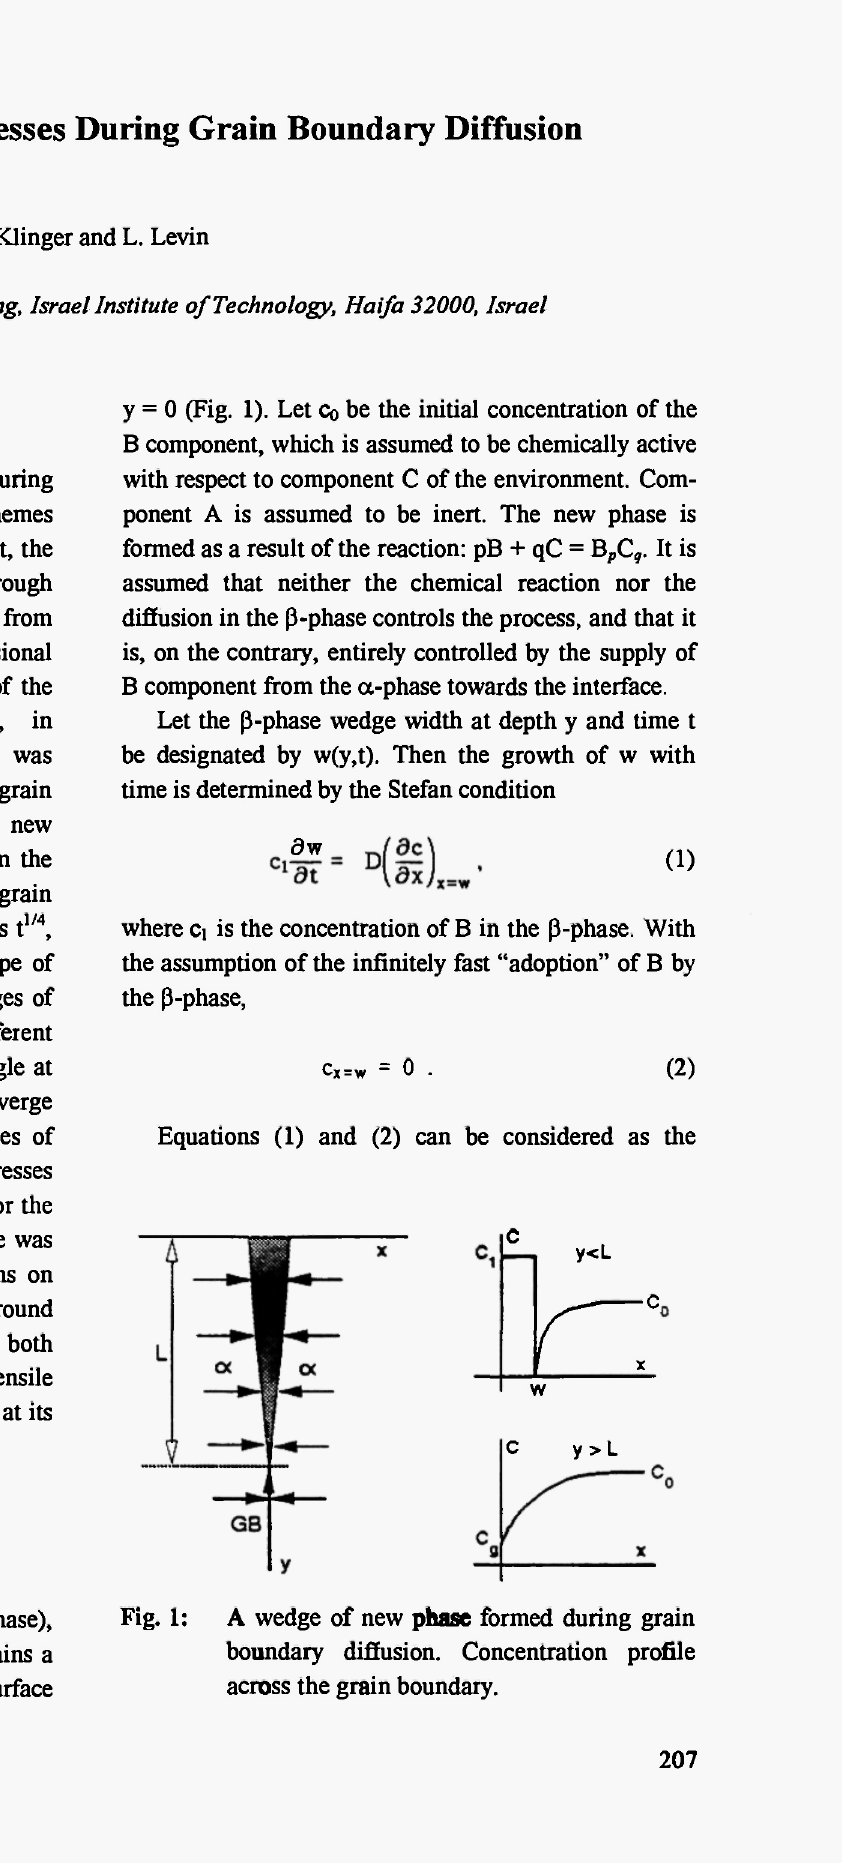
Fig. 1: A wedge of new phase formed during grain boundary diffusion. Concentration profile across the grain